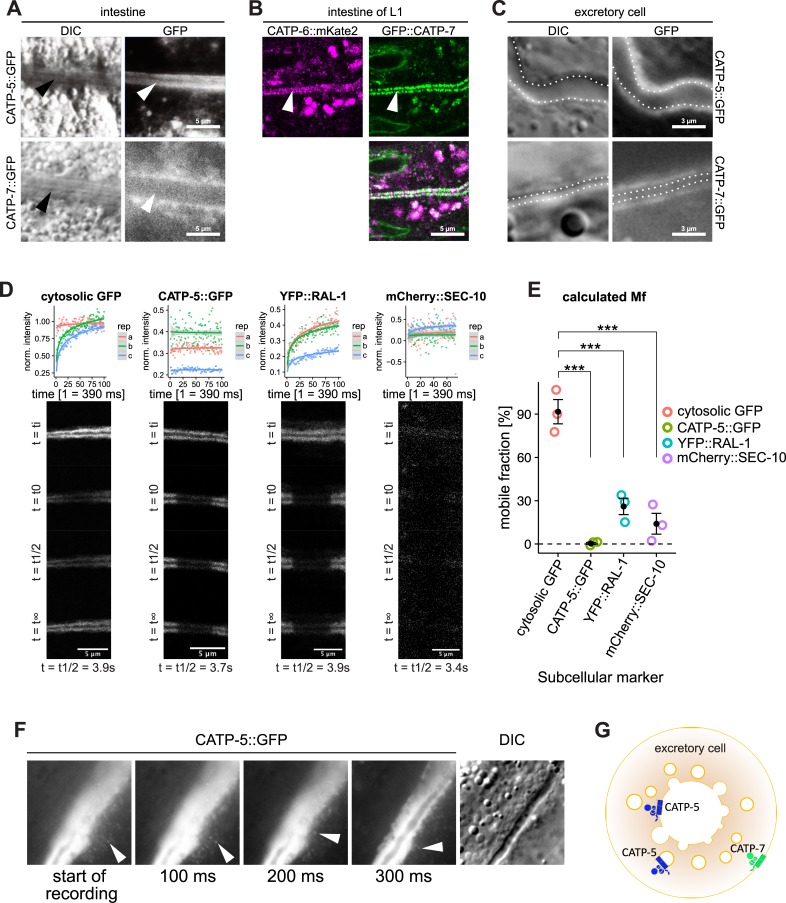
P5B expression in intestinal cells and the excretory cell.(A) Expression of transgene CATP-5::GFP vs. transgene CATP-7::GFP in intestinal cells. Ex [Pcatp-5catp-5::gfp;rol-6(d)] and Ex [Pcatp-7catp-7::gfp;rol-6(d)]. Arrowheads indicate apical brush border. (B) Expression of native CATP-6:;mKate2 vs. native GFP::CATP-7 in intestinal cells of L1. catp-6(dx183[catp-6::gfp::3xFlag + loxP]) IV and catp-6(dx179[catp-6::degron::mKate2::3xFlag + loxP]) IV. (C) Expression of transgene CATP-5::GFP vs. transgene CATP-5::GFP in the excretory cell. Ex [Pcatp-5catp-5::gfp;rol-6(d)] and Ex [Pcatp-7catp-7::gfp;rol-6(d)] (D) FRAP experiment (60 s bleaching) of transgene CATP-5::GFP vs. cytosolic GFP, YFP::RAL-1 and mCherry::SEC-10. catp-5(tm4481); Ex [Ppgp-12catp-5::gfp;rol-6(d)], bgIs312[pes-6::gfp], xnIs459[yfp::ral-1a + unc-119(+)] III and xnIs484 [mCherry::sec-10 + unc-119(+)]. (E) Calculated mobile fraction (Mf) of FRAP experiment. ANOVA, Tukey post-hoc test, adj. p-value: *** ≤ 0.001. (F) CATP-5::GFP positive vesicles (arrowheads) escape from ruptured excretory cell. (G) Schematic overview of CATP-5::GFP and CATP-7::GFP localization in the excretory cell.